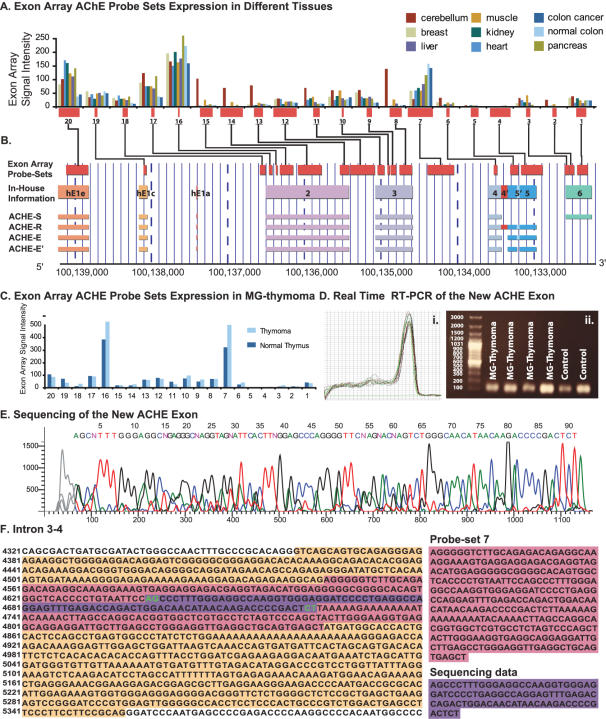
ACHE gene structure, alternative transcripts and protein products, and the discovery of a Novel ACHE exon.(A) Signal expression of ACHE exon array probe-sets in healthy pancreas, liver, muscle, kidney, heart, cerebellum and breast, colon cancer and healthy colon of Affymetrix exon array sample data sets, aligned to known isoforms annotations. Probe set number 7 (that lies within intron 3–4) and probe set number 16 (which is within constitutive exon 2) exhibit relatively high expression. (B) Chromosomal location of ACHE on the reverse strand of chromosome 7 q22. The different ACHE variants (R,S,E,E') are displayed in separate rows (data from [78]). Exon array probe sets (red) aligned to various variant annotation and prediction sources as given in the IGB tool are shown. RefSeq known annotations (as for Exon array genome version, 2003) are shown below them, in green and blue. (C) MG-thymoma expression of ACHE exon array probe sets. Intronic probe set number 12 and probe set 16 exhibits a clearly high expression in MG-thymoma. The signal intensity ACHE expression in MG-thymoma is significantly higher then in all other tissues, including colon cancer, (see (A) above). Real time (i) and RT-PCR (ii) expression of the novel exon between introns 3 and 4, on both MG-thymoma and healthy thymus samples. (E) Sequencing results of the RT-PCR product for the probe set between exons 3 and 4. (F) The sequence identified matches a portion of the target region, and contain AG-CT splice sites.